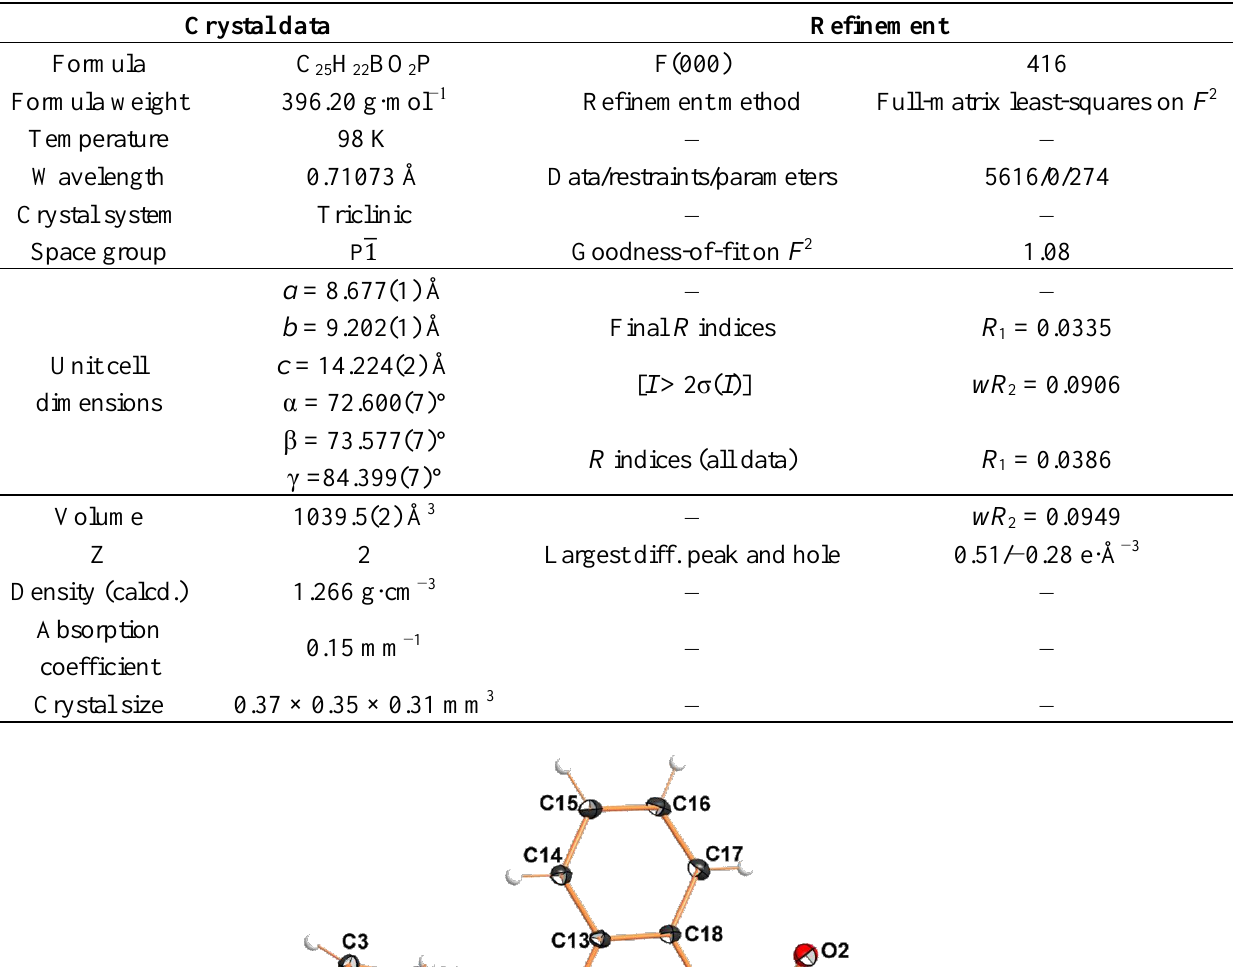
Table 1. Crystal data and structure refinement for compound 4 .